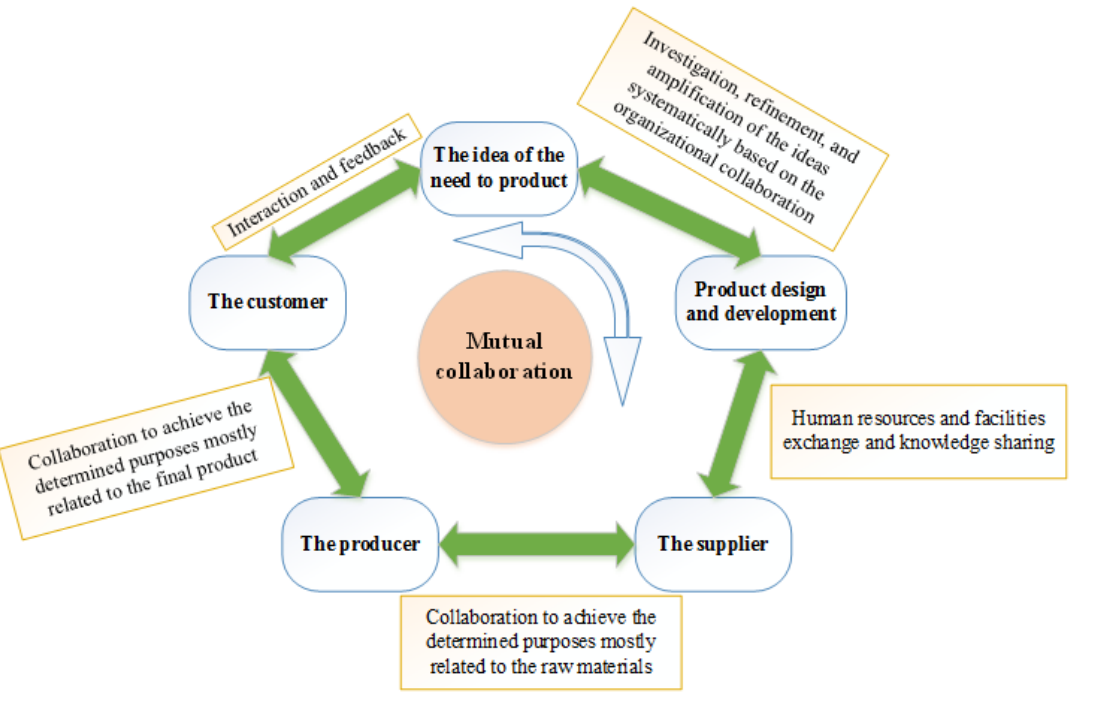
Fig. 3. The collaboration model in the